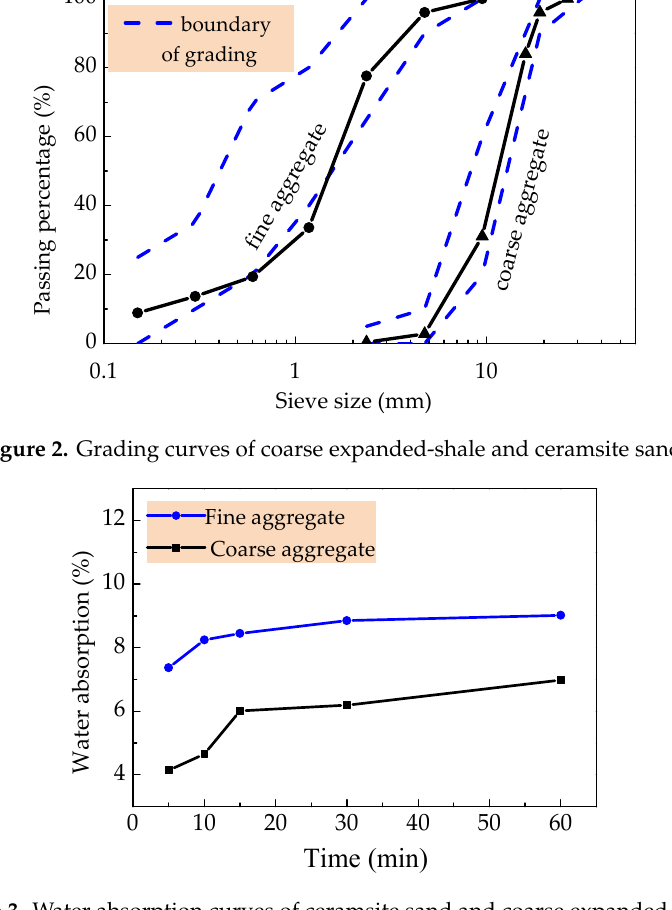
Figure 3. Water absorption curves of ceramsite sand and coarse expanded-shale.